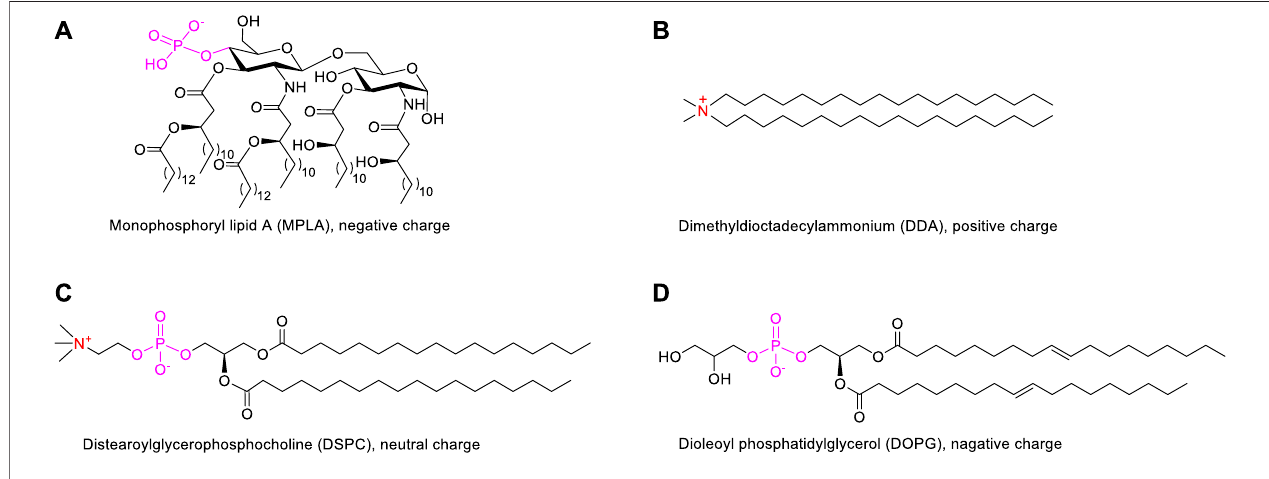
FIGURE 2 | The structures of MPLA adjuvant (A) and auxiliary lipids including cationic DDA (B) , neutral DSPC (C) and anionic DOPG (D) .